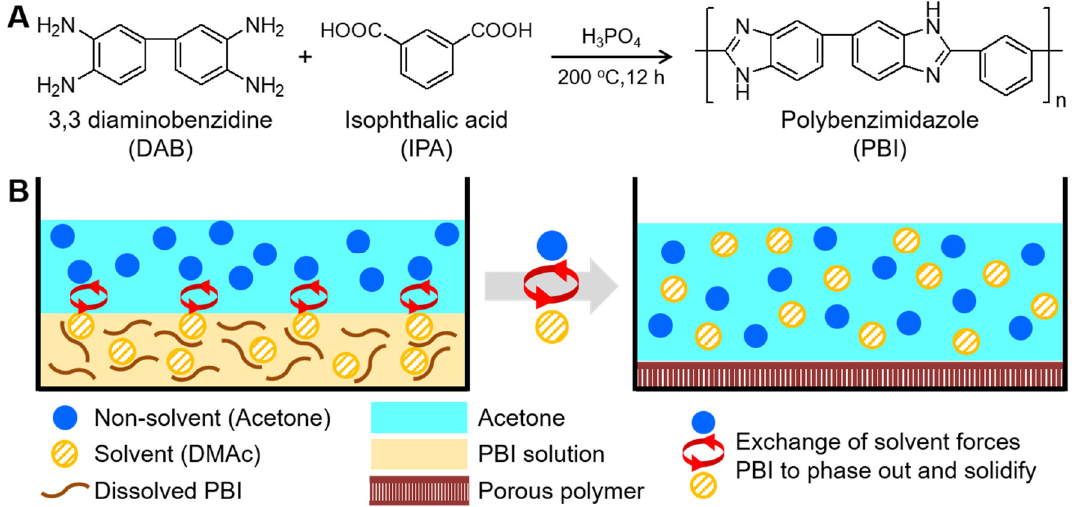
Figure 1. ( A ) Synthesis of meta -polybenzimidazole ( m -PBI) and ( B ) the non-solvent induced phase separation mechanism to achieve porosity.